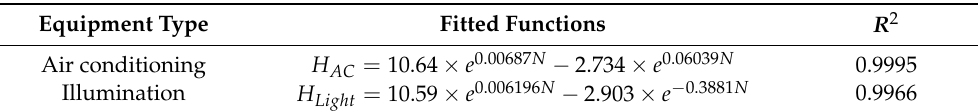
Table 9. Patterns of average daily running hours of air conditioning and illumination with the occupant number.